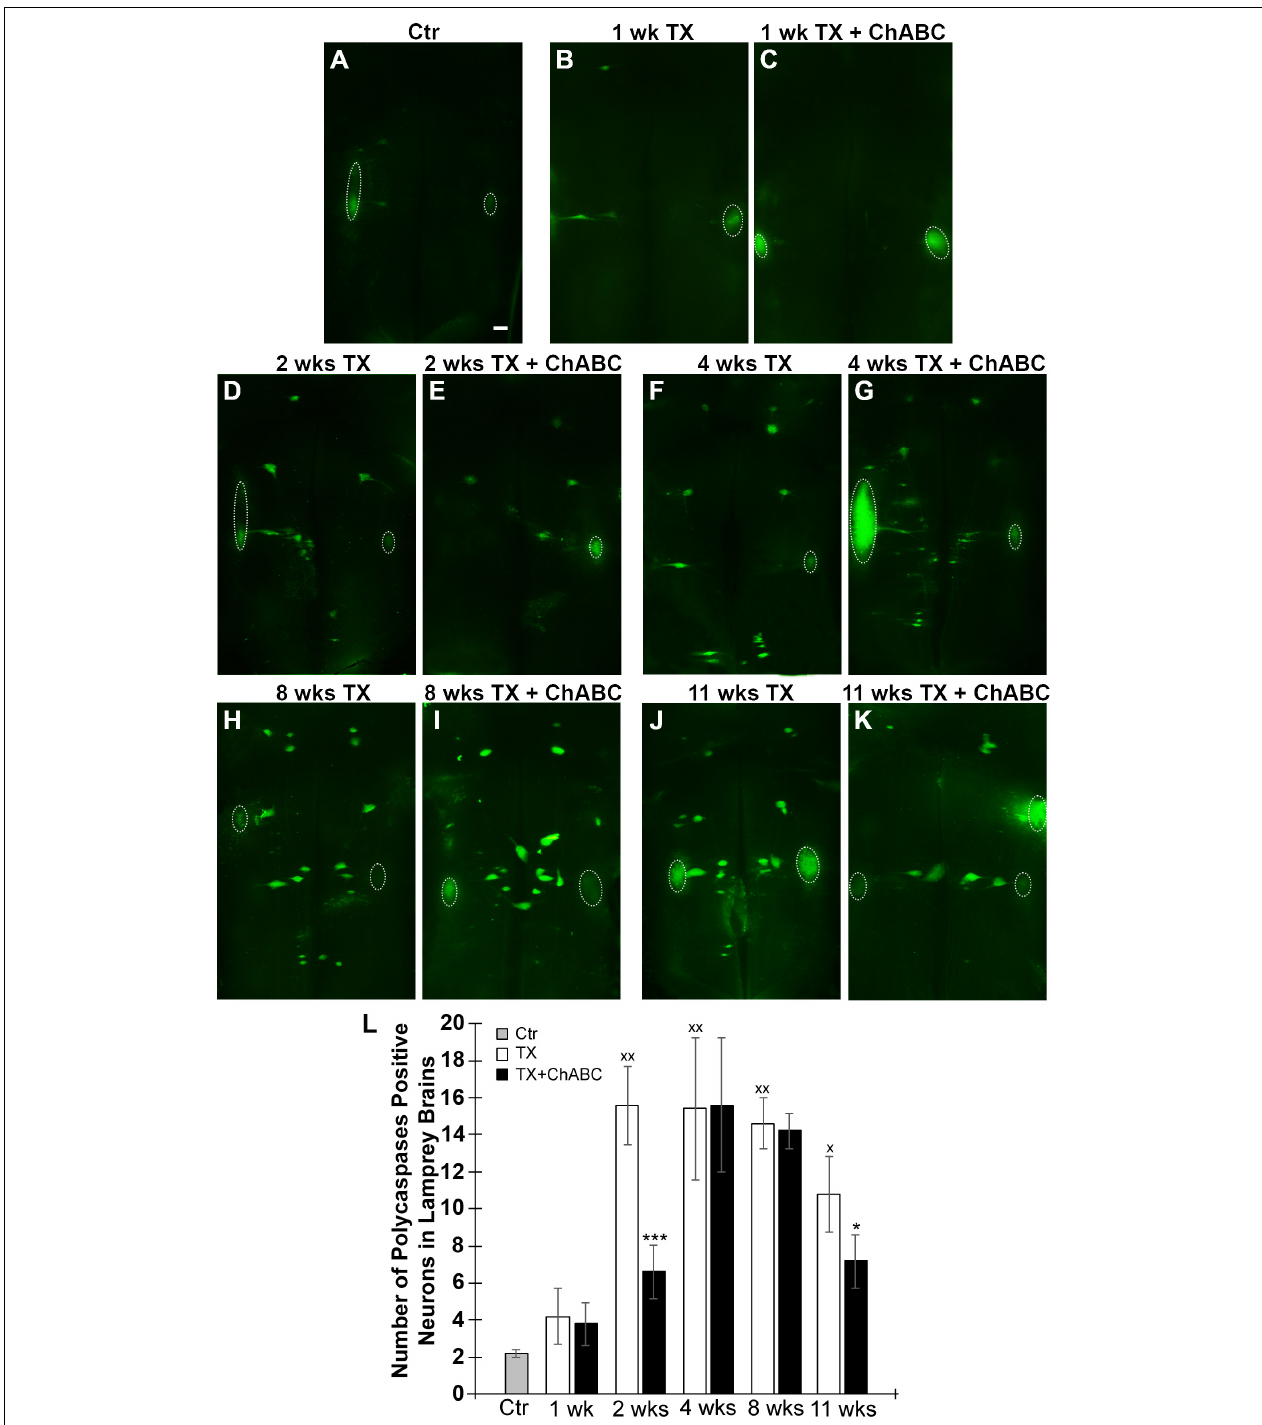
FIGURE 3 | Polycaspase activation in RS neurons is suppressed by ChABC. Spinal cords were transected at the 5th gill with/without ChABC, and allowed to recover for 1–11 weeks. (A) FLICA on control brain (without TX). ChABC did not affect the number of polycaspase positive (polycaspase FLICA) RS neurons at 1 week post-TX ( B vs. C ), but reduced it significantly at 2 weeks ( D vs. E ) and at 11 weeks ( J vs. K , * p < 0.05), but not at 4 ( F vs. G ) or 8 weeks ( H vs. I ). (L) A graph showing the number of polycaspase positive identified RS neurons per brain at 1, 2, 4, 8, and 11 weeks post-TX with or without ChABC. Polycaspase positive RS neurons increased greatly at 2, 4, 8, and 11 weeks comparing to control brain ( x p < 0.05, xx p < 0.01); ChABC reduced polycaspase positive RS neurons at 2 (*** p < 0.001) and 11 weeks (* p < 0.05). The large fluorescent accumulations (outlined by circles) seen laterally are out of focus cranial motor nuclei, which are axotomized close to their perikaryal at the time of live dissection, so their neurons rapidly turn caspase-positive. n = 5 lampreys per group. Error bars: SEM. Scale bar: 200 µ m.